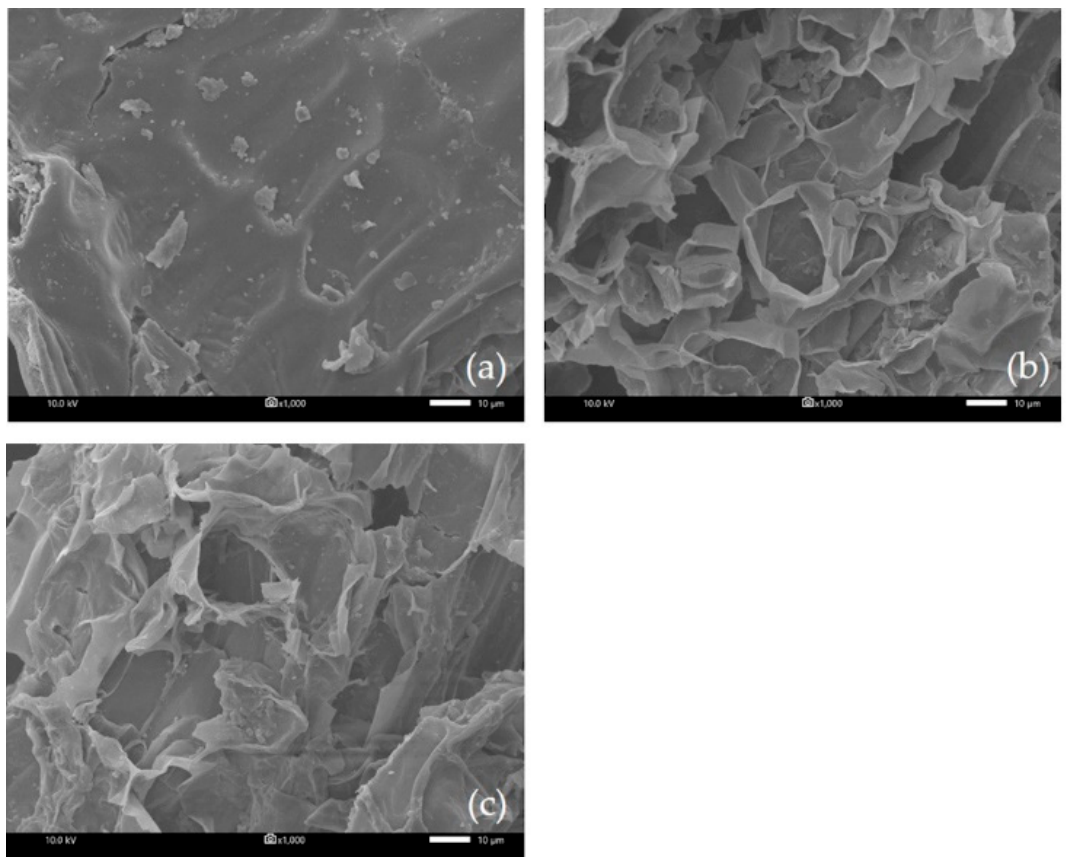
Figure 6. SEM image of Siam cardamom leaf sheath ( a ) raw material, ( b ) Siam cardamom treated by MA-SDE, and ( c ) Siam cardamom treated by SDE.